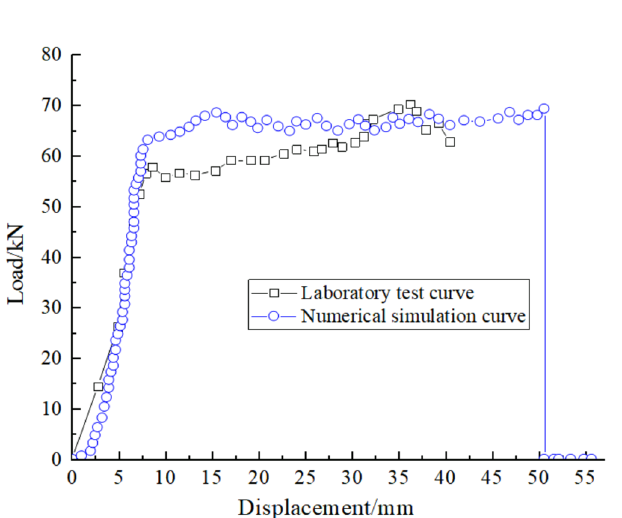
Figure 7. Comparison curve of the pull-out test